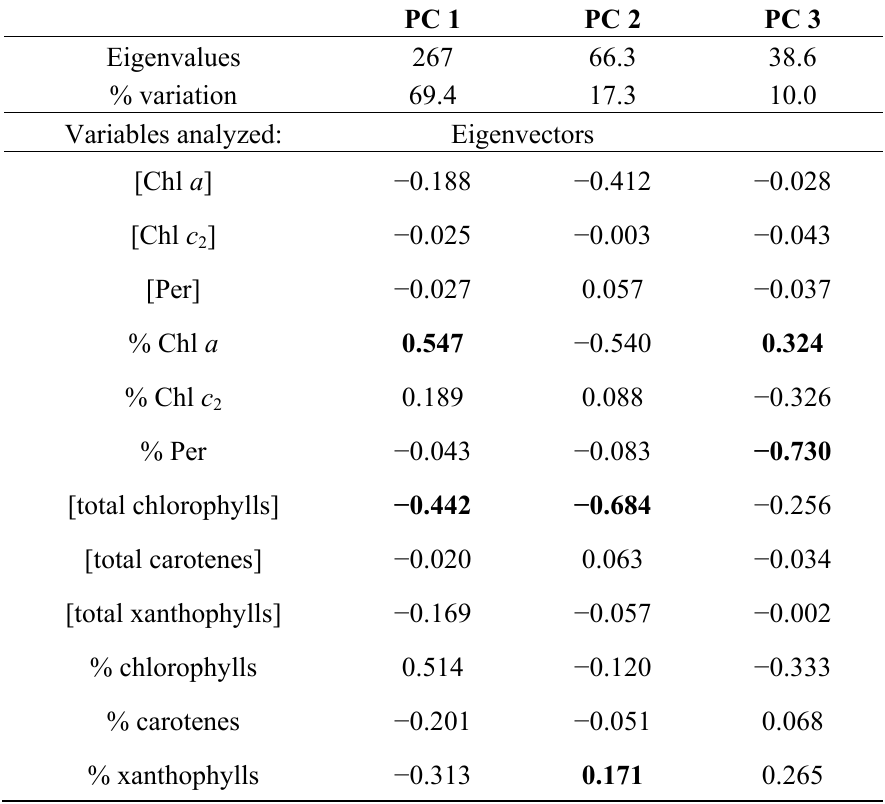
Table 2. Principal Components Analysis (PCA) for variations among the main pigments (or pigment groups) of A. cervicornis and P. porites based on 5 colonies sampled per species. Percentages of pigment groups are relative to each other. Eigenvectors in bold represent the highest values for PC1 and